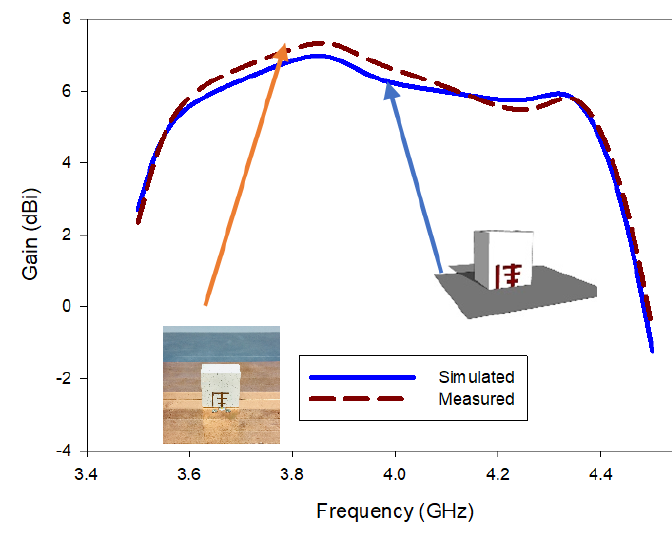
Figure 14. Radiation patterns of the proposed antenna at 3.7 GHz.